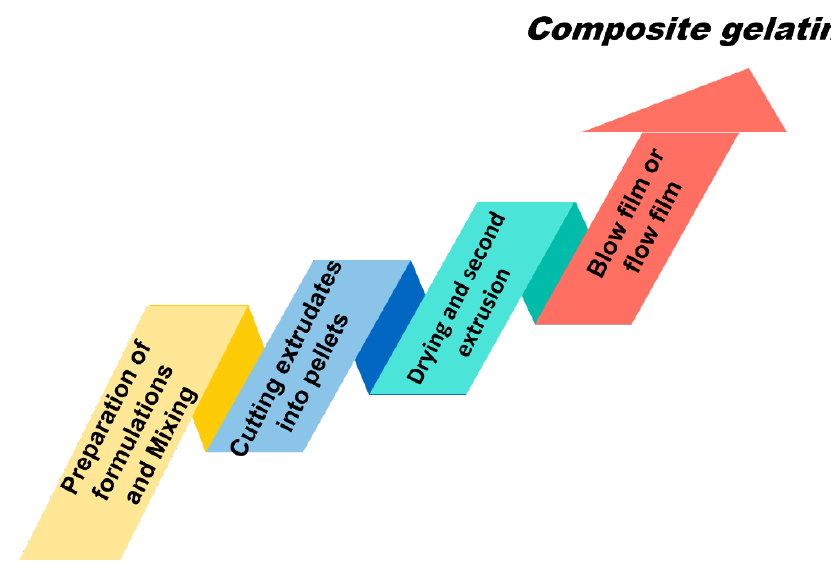
Figure 5. Steps for the preparation of edible composite film for the extrusion method.